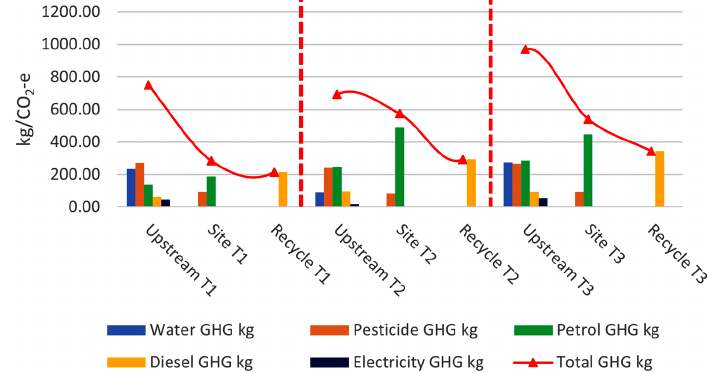
Figure 5. Life cycle of GHG emissions in traditional cemetery green space maintenance